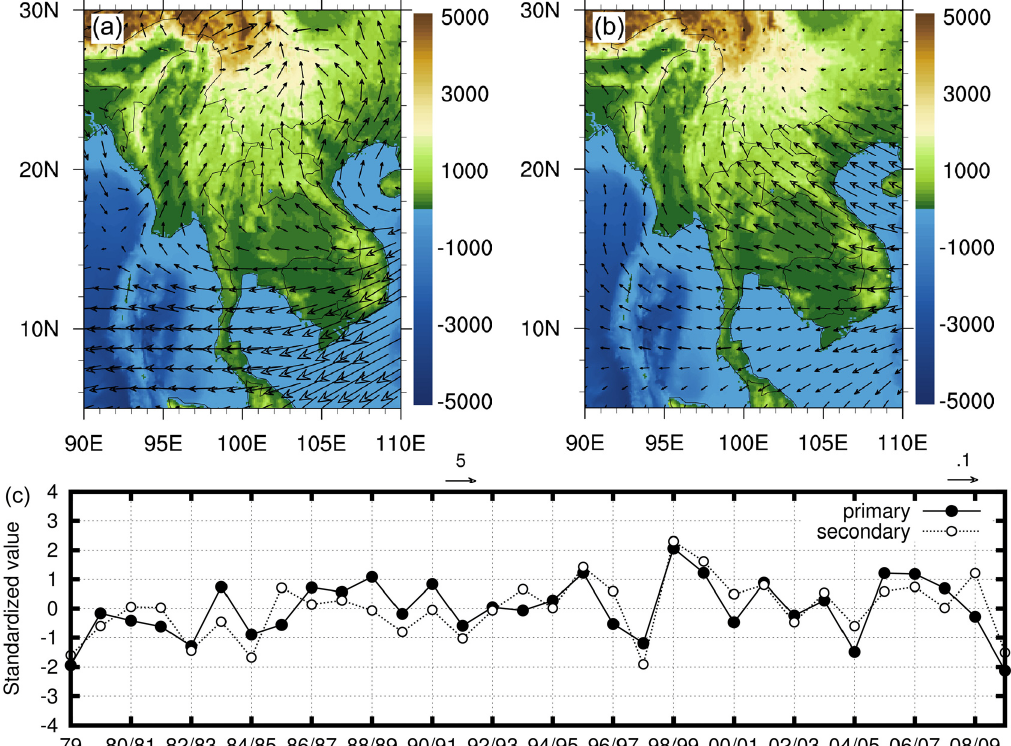
Figure 1. Spatial patterns of ( a ) the climatic wintertime wind at 850 hPa (unit is m∙s −1 ) and ( b ) the leading mode and ( c ) the corresponding time series, PC1 (principal component 1). Note that shading represents topography (units are